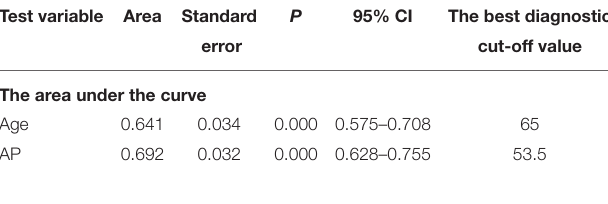
TABLE 5 | ROC curve analysis of AHRE.